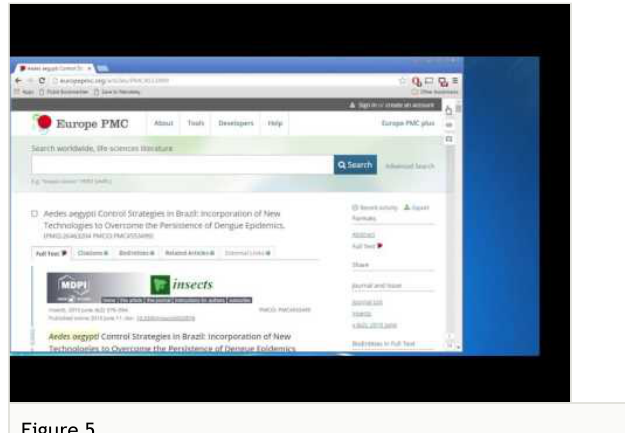
Figure 5. A demo of Hypothes.is marking up a Wolbachia